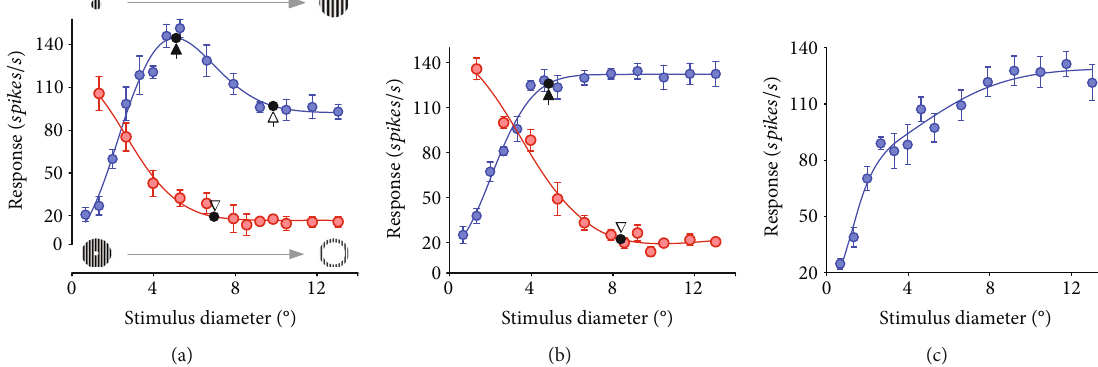
Figure 1: Samples of response tuning curves showing RF property of di ff erent types of V1 neurons. (a) Size-tuning responses to circular patch grating stimuli (upper left to right corner) with increasing outer diameter (blue solid circles with error bars, n = 56 ) and to annular grating stimuli (lower left to right corner) with increasing inner diameter (red solid circles with error bars, n = 48 ) for neurons with evident surround suppression (SS). The blue and red solid curves are the best fi ts of size-tuning responses with DoG functions. (b) Size- tuning responses to circular patch grating stimuli with increasing outer diameter (blue color) and to annular grating stimuli with increasing inner diameter (red color) for neurons with no surround suppression (NOS). (c) Size-tuning responses to circular patch grating stimuli with increasing outer diameter for neurons showing facilitated response to sRF stimulation. Solid arrows indicate the diameter of cRF corresponding to the maximum response (in (a)) or 95% of the saturation response (in (b)), and the open arrow de fi nes the outer boundary of sRF in the size-tuning response to circular patch grating stimuli. Arrowheads indicate the nonresponsive area in the size-tuning response to annular grating